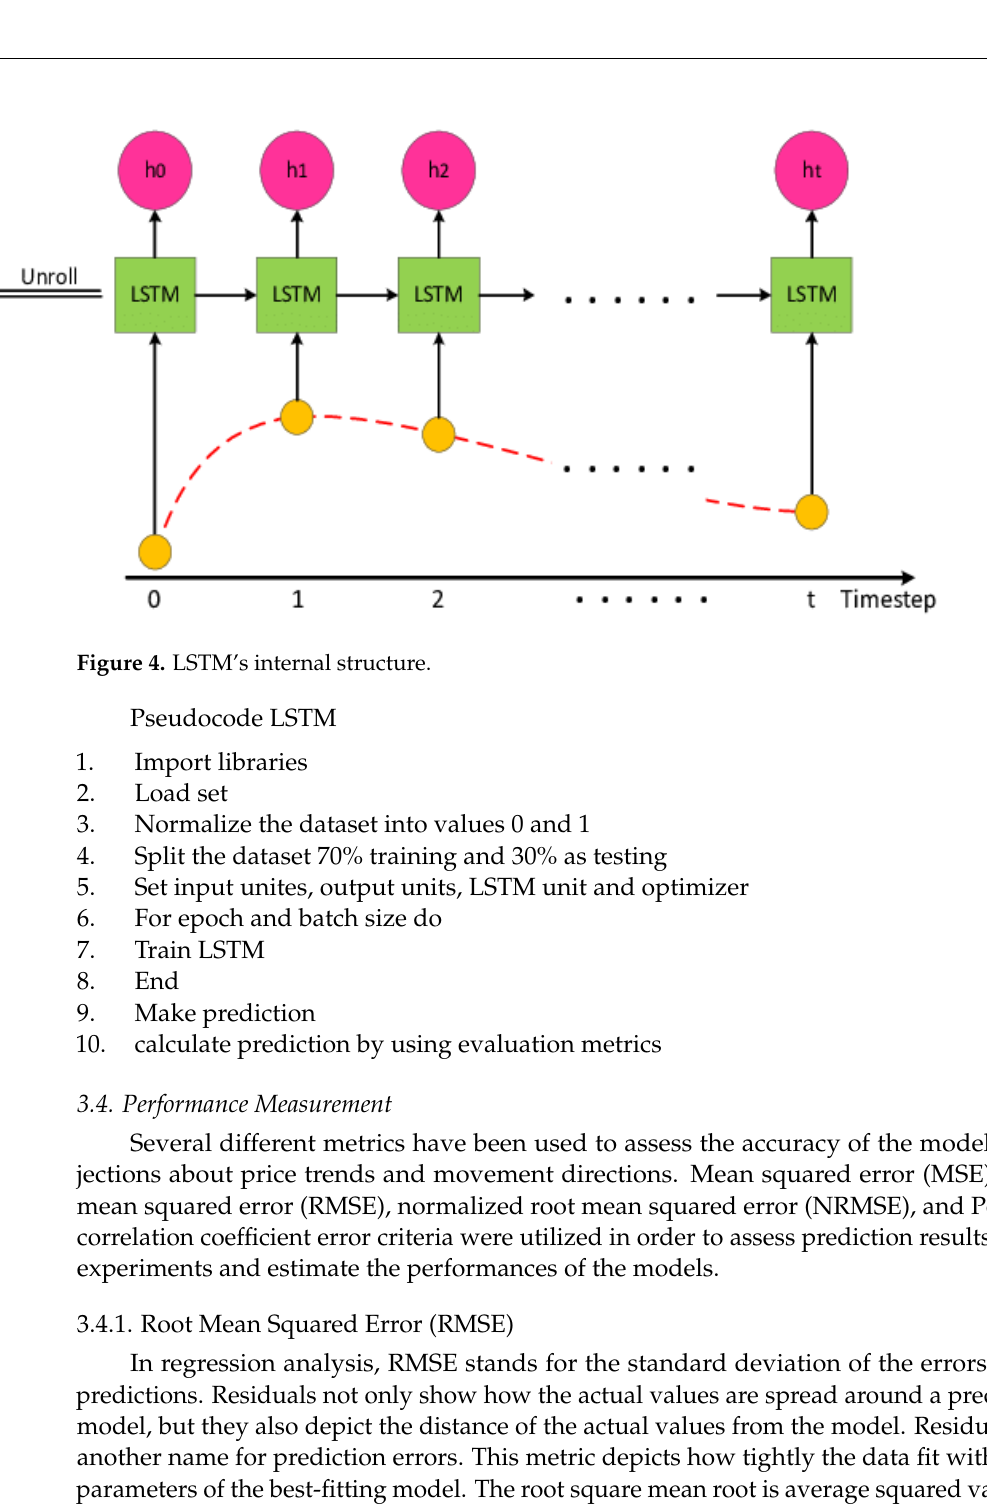
8 of 26 Figure 3. MLP structure to predict the stock market. 3.3.2. Long Short-Term Memory (LSTM) The LSTM model is an extension of the recurrent neural network (RNN) in its more complex form. Utilizing memory units that are able to update the previous hidden state is how this model manages to preserve long-term memory. It offers feedforward at each individual neuron [32–34]. The output of an RNN is not only reliant on the neuron input and the weight of the present neuron, but also dependent on the neuron inputs of the neurons that came before. Due to this functionality, it is feasible to understand the temporal linkages that exist in a long-term sequence. The exploding and vanishing